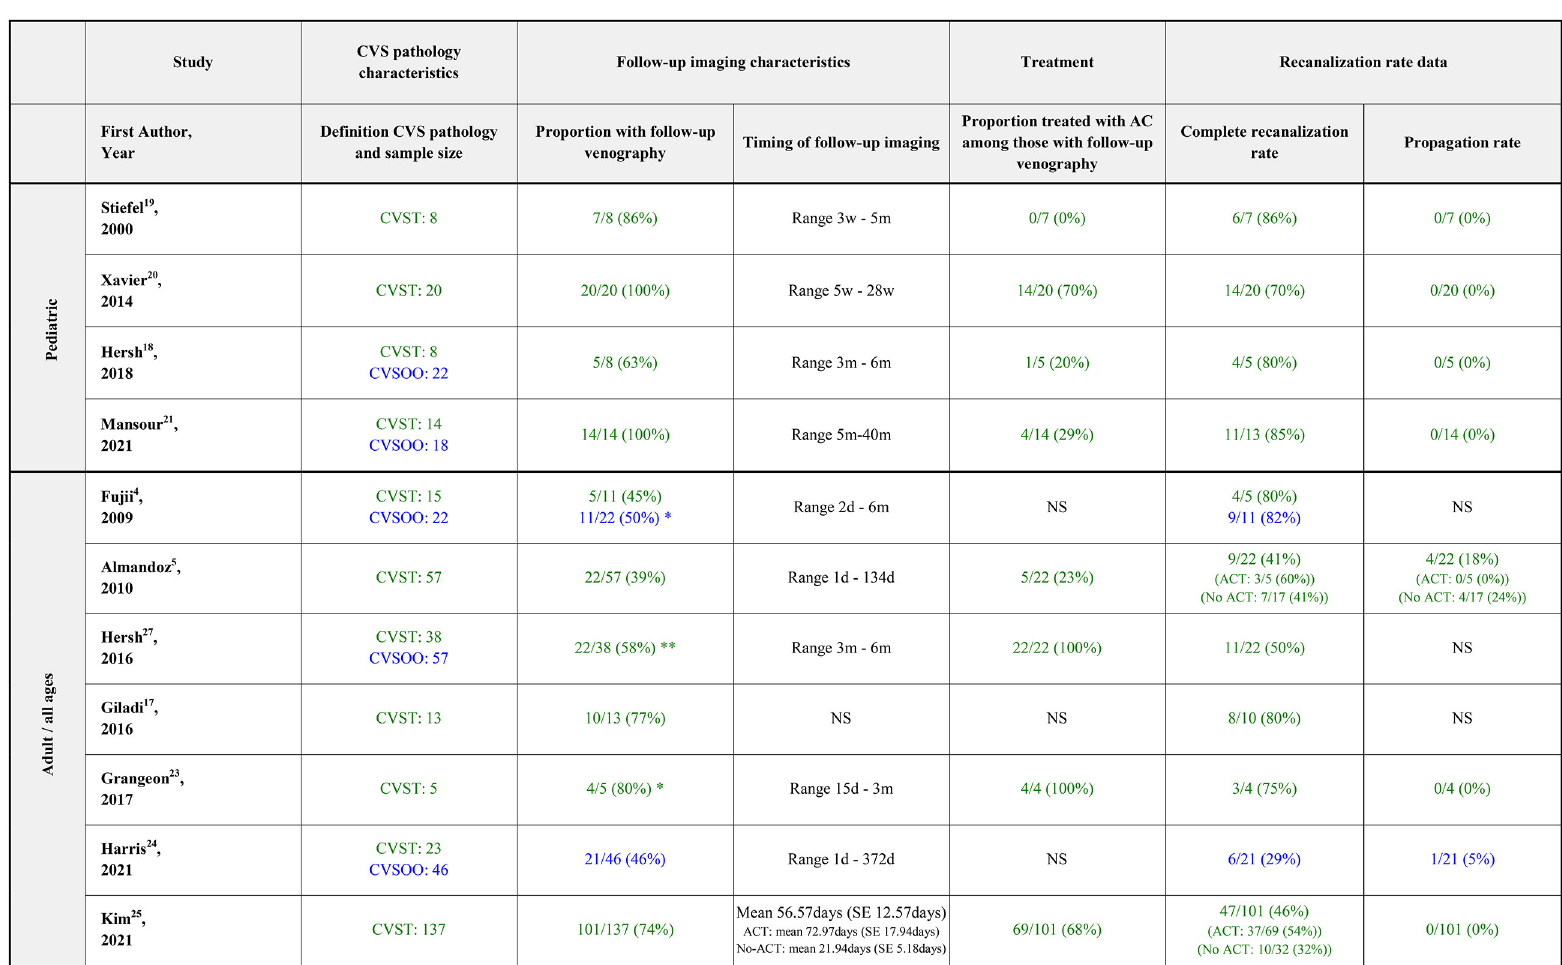
TABLE 5 Recanalization